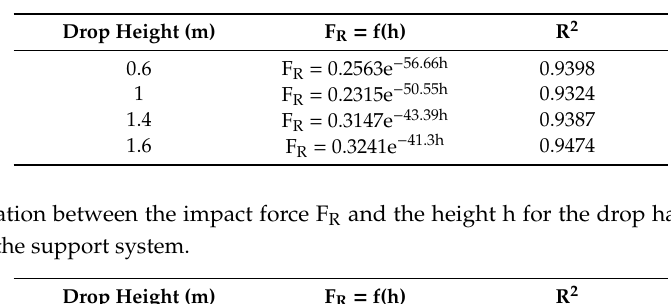
Table 5. Correlation between the impact force F R and the height h for the drop hammer weight of 90 kg without the support system.